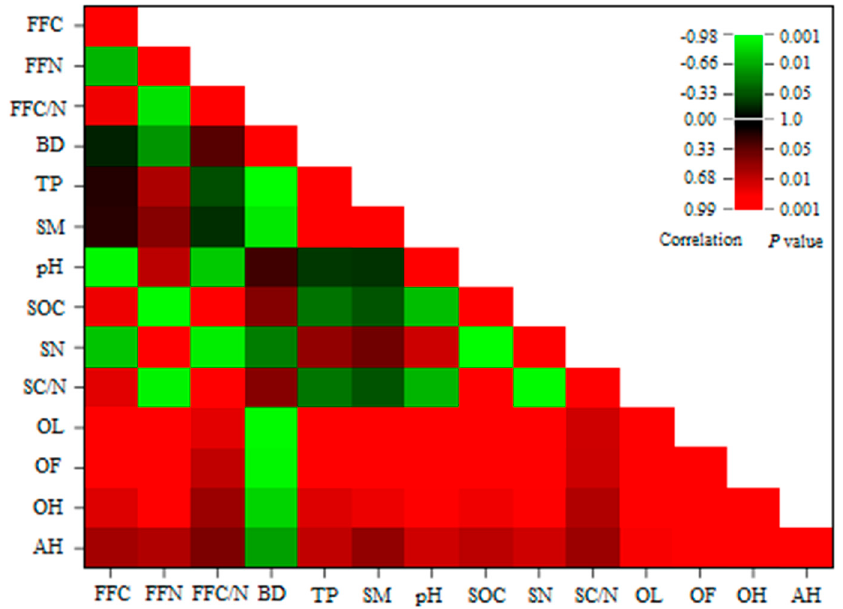
Figure 6. Pearson correlation coefficients (Heat map) of studied humus layers: thickness, forest floor, and soil properties.